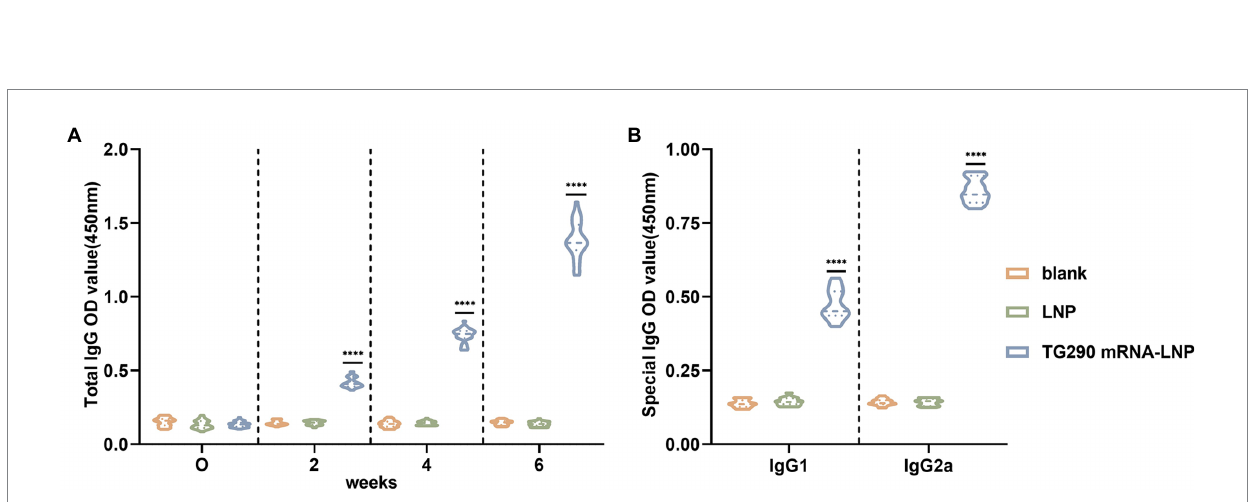
FIGURE 3 TG290 mRNA-LNP vaccine elicited humoral immunity response in BALB/c mice. (A) Total TG290-specific IgG; (B) TG290-specific IgG1, IgG2a. The OD450 value of total TG290-specific IgG was recorded at 0-, 2-, 4-, and 6-weeks post-vaccination ( n = 10). The OD450 value of TG290-specific IgG subclass (IgG1, IgG2a) was recorded at 6 weeks post-vaccination ( n = 5). **** p < 0.0001, analyzed by One-way ANOVA with multiple comparisons (compare the mean of each group with the mean of every other